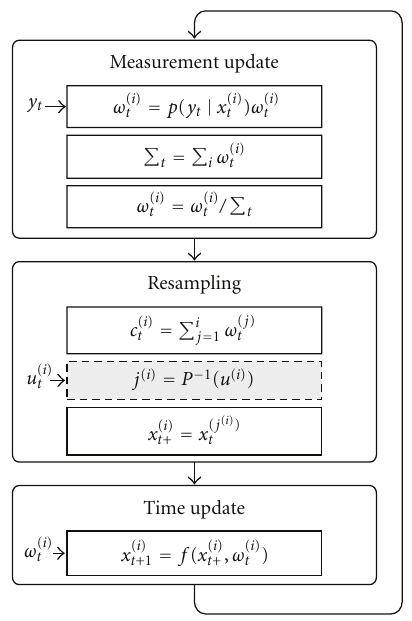
Figure 3: GPU PF algorithm. The outer boxes make up the CPU program starting the inner boxes on the GPU in correct order. The figure also indicates what is fed to the GPU; remaining data is generated on it.